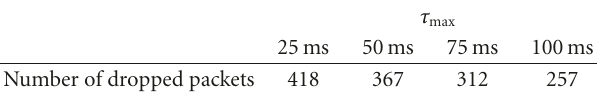
Table 3: Number of dropped packets versus τ max for velocity = 90